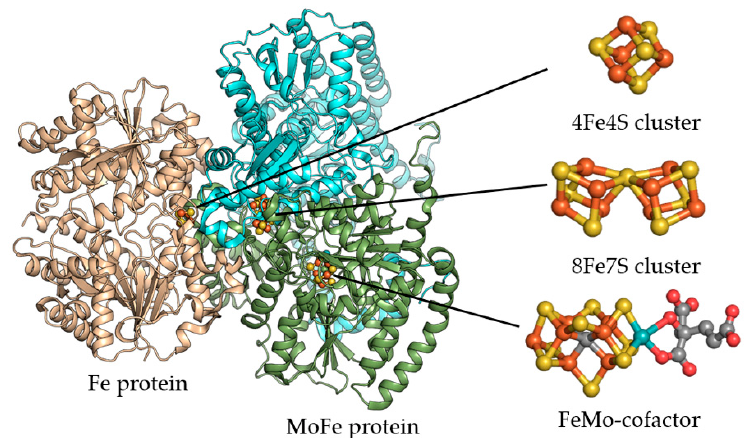
Figure 3. Structure of molybdenum nitrogenase, 4Fe4S cluster, 8Fe7S cluster, FeMo-cofactor, PDB code 2AFK.